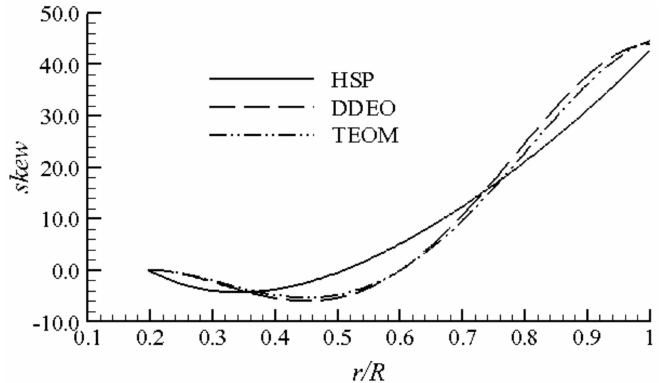
Figure 7. Comparison of skew distributions.